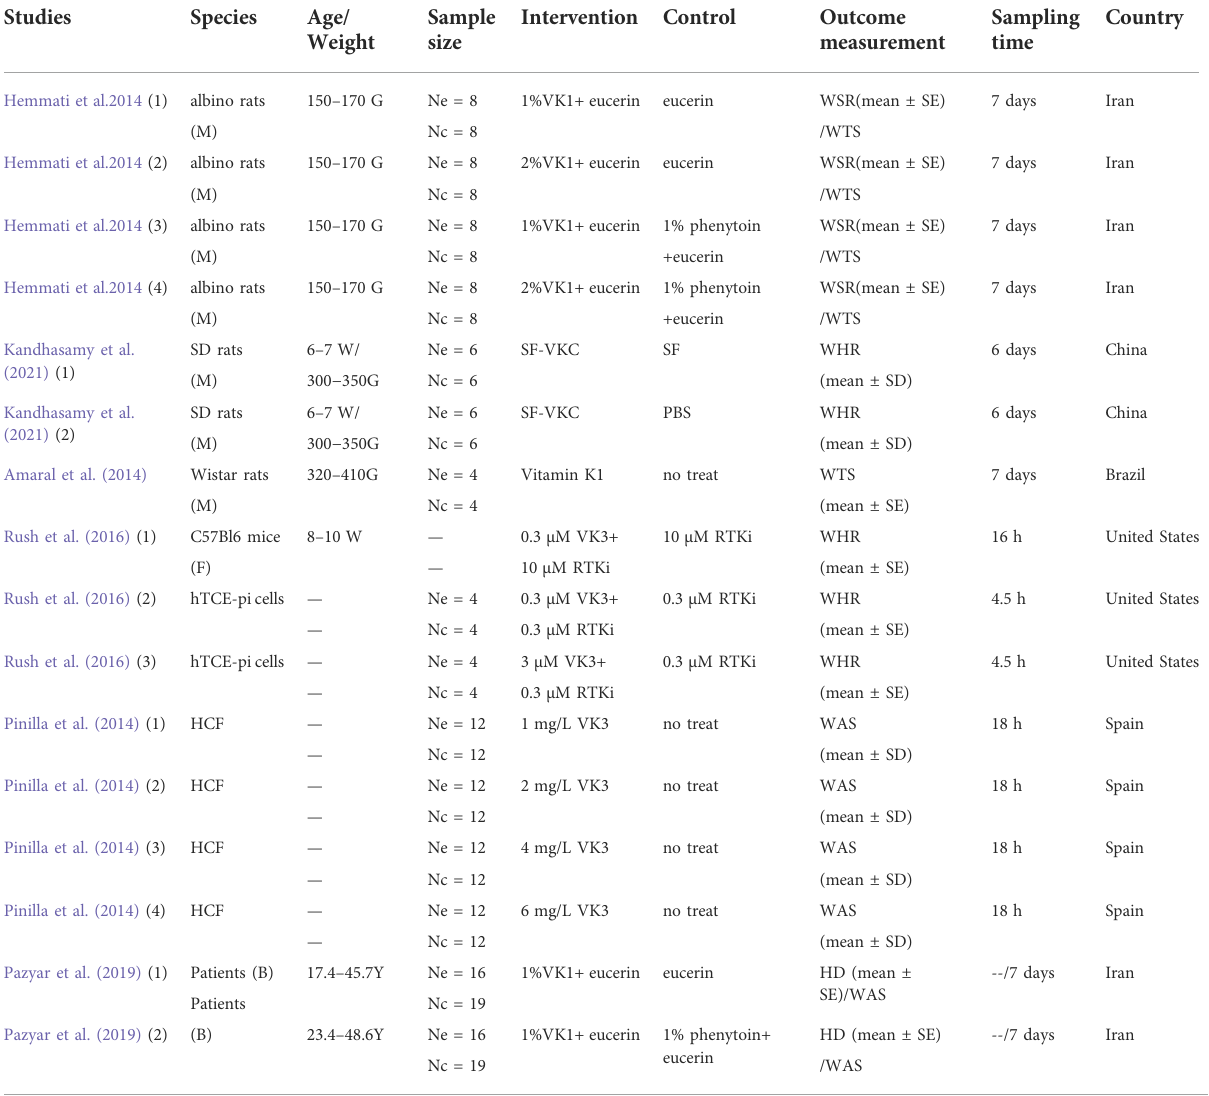
TABLE 1 Characteristics of studies used in